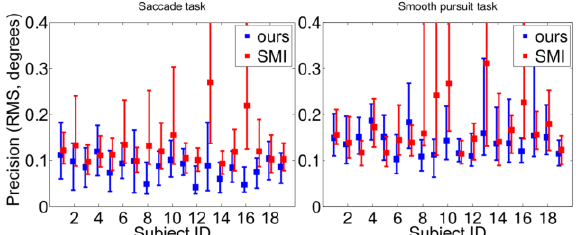
Figure 16. Precision values for the saccade task (left panel) and the smooth pursuit task (right panel) for the presented and SMI systems. See caption of Figure 14 for details. Lower values are